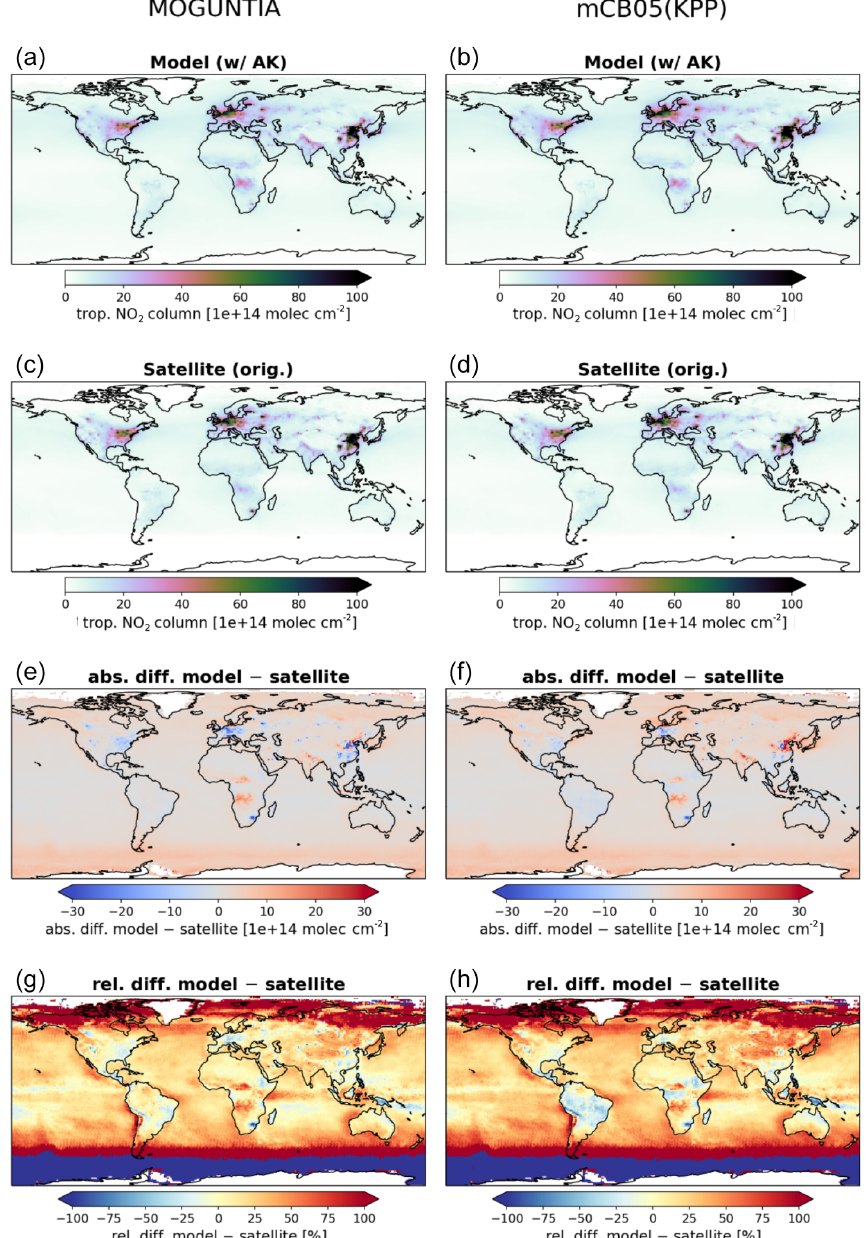
Figure 3. Annual mean comparison of tropospheric NO 2 vertical columns (molec.cm − 2 ) for the two chemistry schemes MOGUNTIA and mCB05(KPP) (a, b) against the Ozone Monitoring Instrument (OMI) satellite data (c, d) using the respective averaging kernel information for 2006. The absolute (e, f) and relative (g, h) differences are also